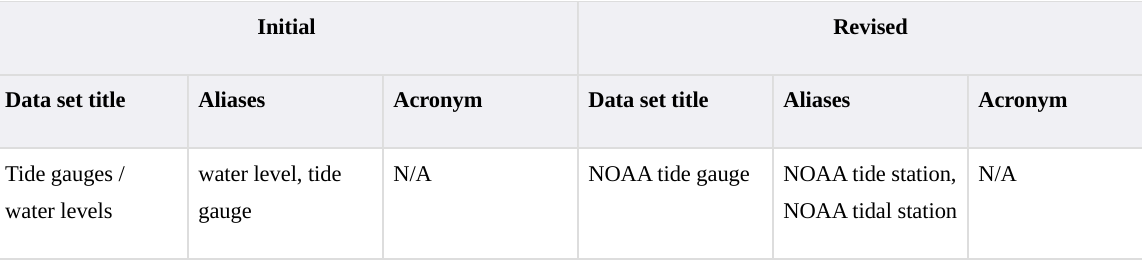
Table B1. Example of the initial and revised data set